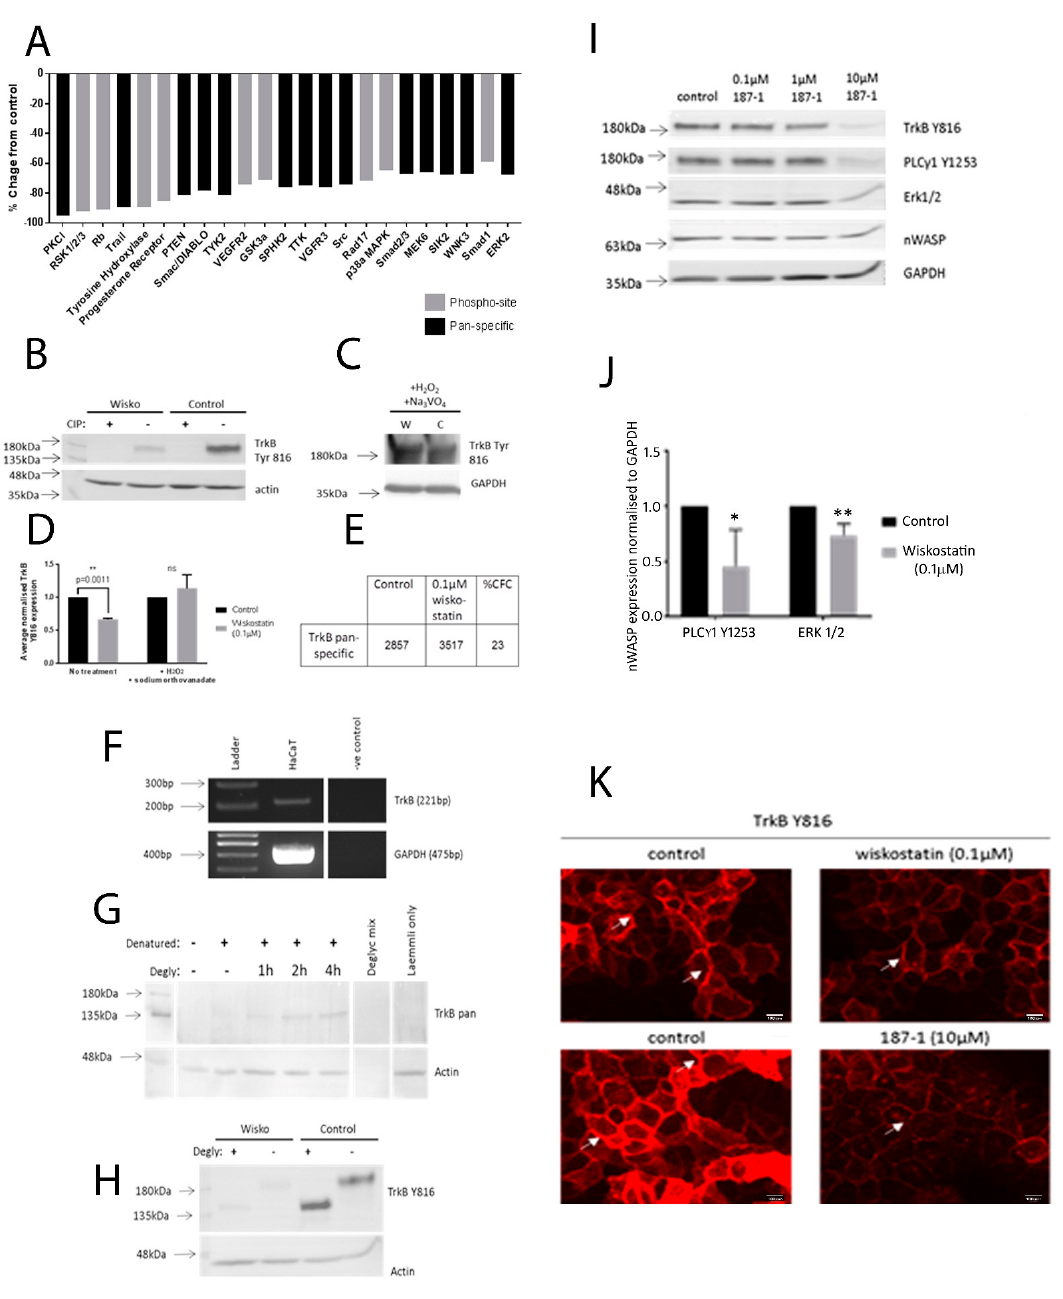
Figure 6. Protein signalling changes in response to the wiskostatin treatment. ( A ) Changes in the total protein expression or phosphorylation sites in response to the 0.1 µM wiskostatin treatment for 1 h according to the %CFC. Protein samples that were treated with CIP at 0.6 units/µg for 1 h ( B ). Positive controls ( C ). Integrated densities as a change from the control ( D ). Globally normalised expression of total TrkB protein and %CFC according to protein array analysis ( E ). TrkB transcript expression in the HaCaT cell line ( F ). Protein extracts from HaCaT cells were treated with denaturation and deglycosylation reagents ( G ). Samples from cells treated with 0.1 µM wiskostatin/control were denatured and then deglycosylated to examine the TrkB Y816 activity ( H ). Western blot analysis of TrkB Y816, PLC γ 1 Y1253 and Erk1/2 of HACAT cells treated with 0.1 µM wiskostatin or 10 µM 187-1 ( I , J ). Immunofluorescence analysis of TrkB Y816 expression in HaCaT cells serum starved for 4 h and treated with nWASP inhibitors; scale bar indicates 50 µm ( K ). * indicates statistical significance (* p < 0.05, ** p < 0.01,.ns: not significant).